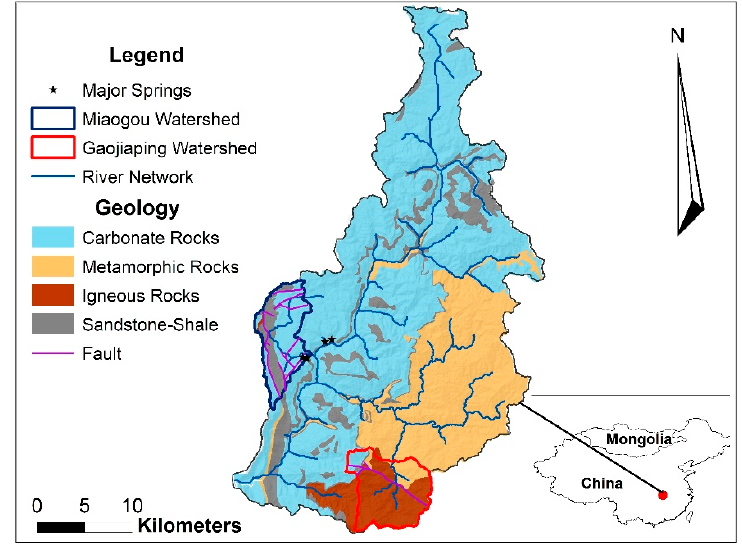
Figure 1. Major geological units in Gaolan River basin, Hubei Province, South China (Source: China Geological Survey).